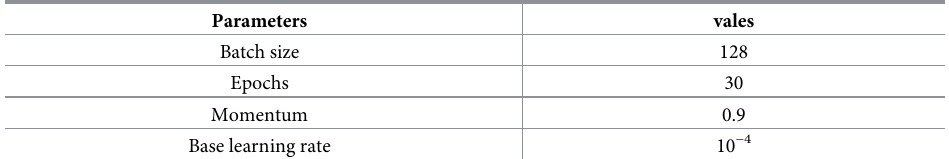
Table 1. CNNs parameters setting for the training process.